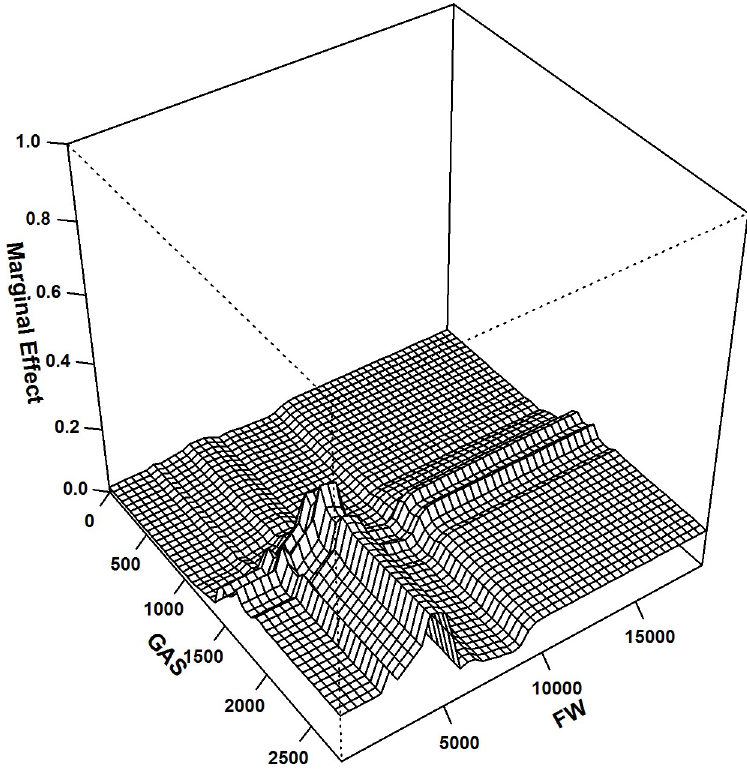
Fig 4. BRT 2-way: Interaction plot for distances to the edges of green areas around settlements and the edges of watercourses; the second most important interaction in the BRT 2-way model; interaction size = 0.53.